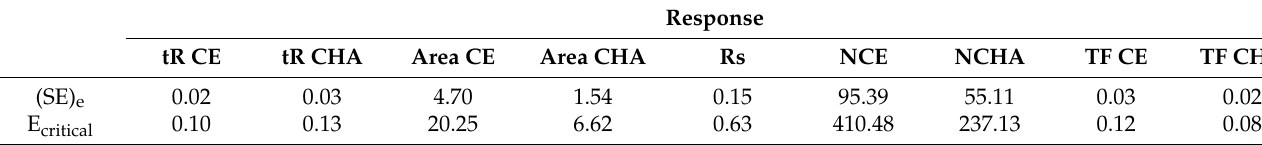
Table 8. SE and E critical values for every response